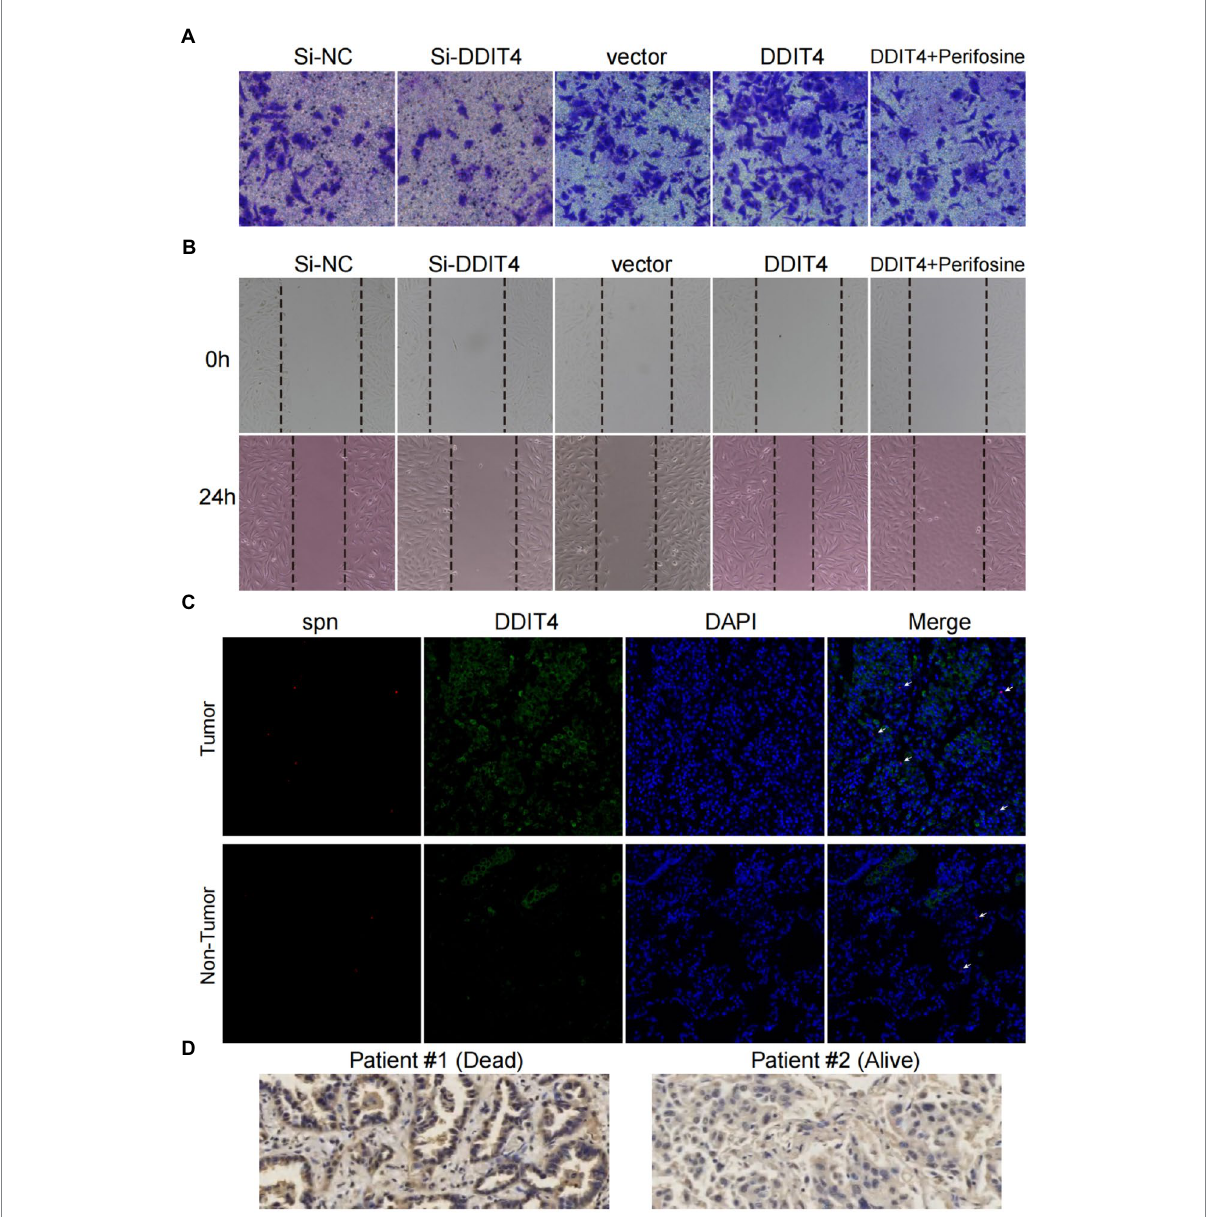
FIGURE 5 High expression of DDIT4 enhances the migratory and invasive abilities of A549 cells and impairs the prognosis of LUAD patients. (A) Transwell migration assays of A549 cells with silencing of DDIT4, overexpression of DDIT4, overexpression of DDIT4 followed by addition of AKT inhibitor perifosine, and blank control. (B) Cell scratch assays of A549 cells with silencing of DDIT4, overexpression of DDIT4, overexpression of DDIT4 followed by addition of AKT inhibitor perifosine, and blank control at 0 and 24 h, respectively. (C) Expression and enrichment of DDIT4 and S. pneumoniae in lung cancer tissues. The white arrows refer to visible S. pneumoniae . (D) Expression of DDIT4 protein detected by immunohistochemistry in LUAD patients with different